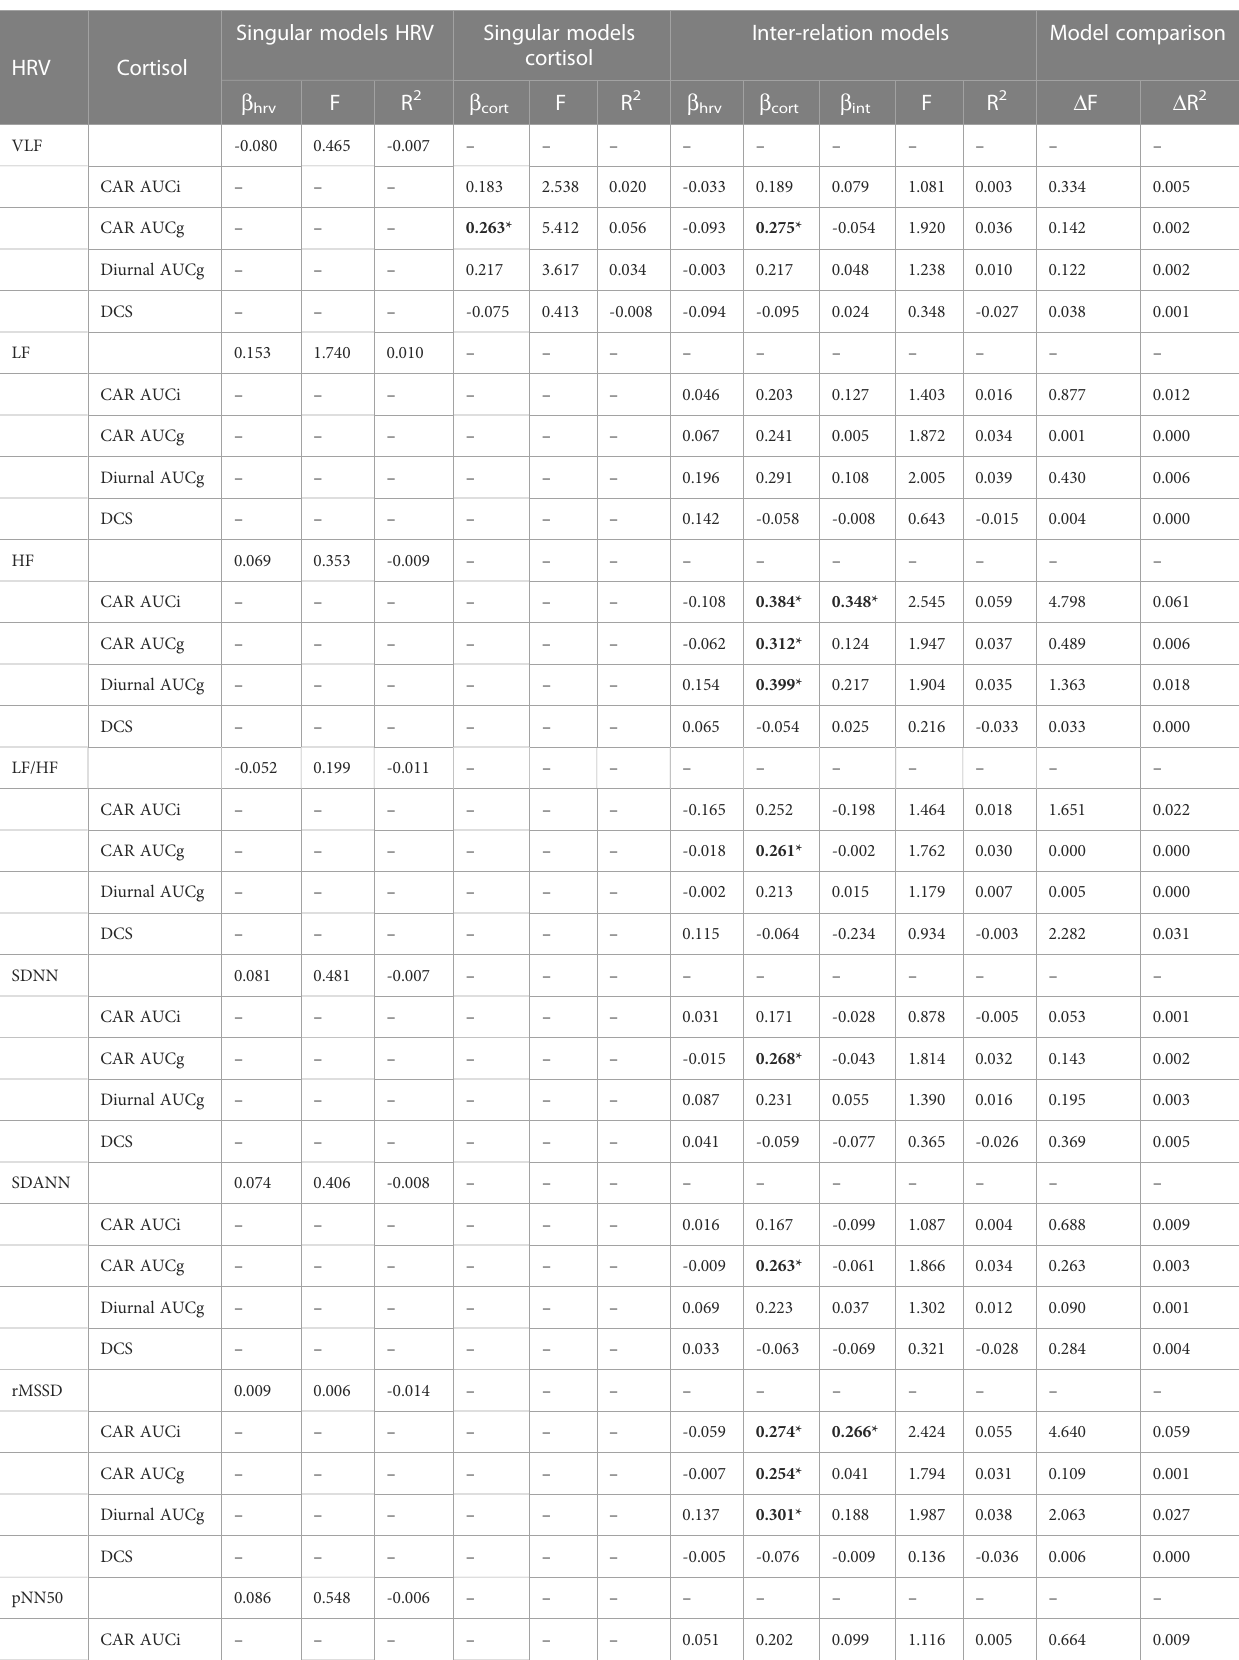
TABLE 2 Singular versus inter-relation model comparisons in pED